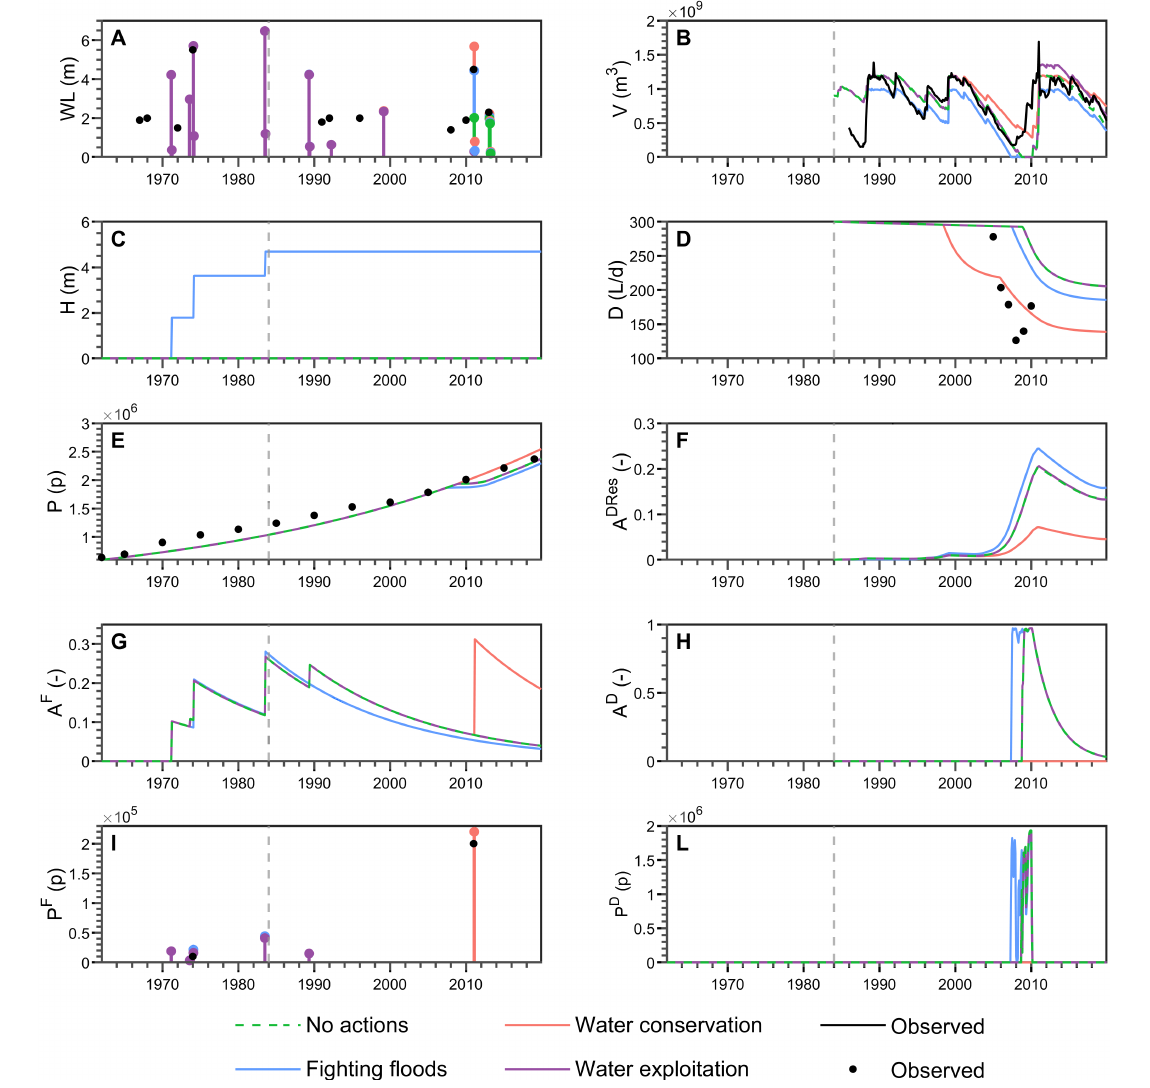
Fig. 5 . Historical analysis on the Brisbane case study considering the three management strategies. (A) water level (WL), (B) reservoir volume (V), (C) levee height (H), (D) per-capita demand (D), (E) population (P), (F) drought awareness of reservoir operator (A DRes ), (G) flood awareness (A F ), (H) drought awareness (A D ), (I) population affected by floods (P F ), and (L) population affected by droughts (P D ). The gray dashed lines indicate the construction of the Wivenhoe